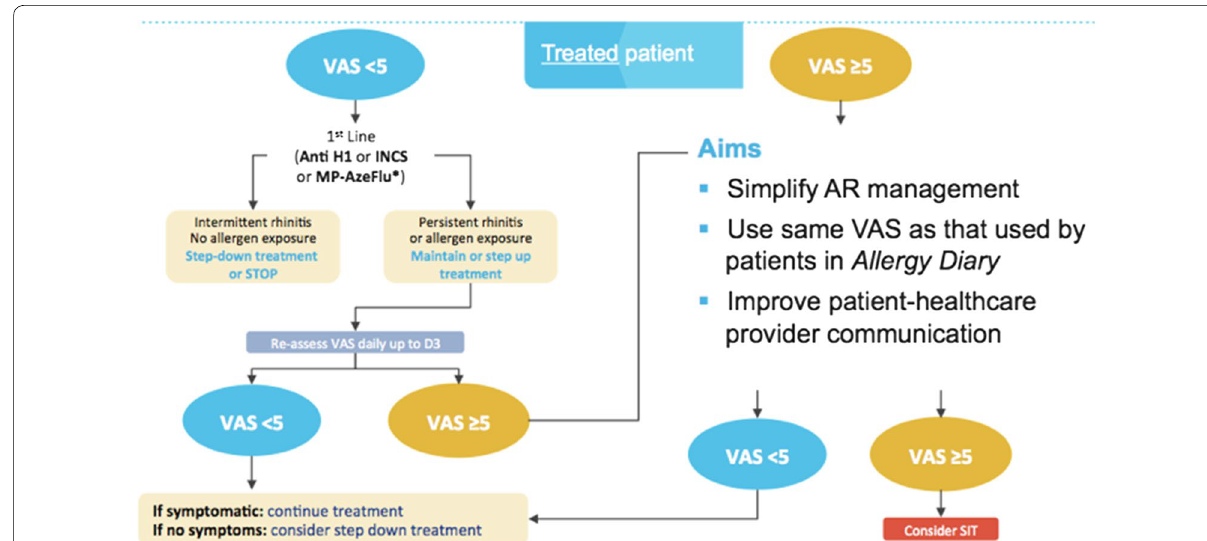
Fig. 4 Clinical decision support systems consensus for allergic rhinitis (from Bousquet et al. [28])